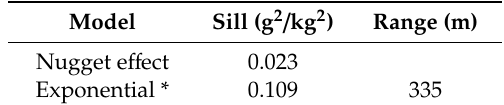
Table 4. Variogram parameters of the fitted model (Figure 11) for predicted SOC obtained from a Partial Least Squares Regression (PLSR) model.